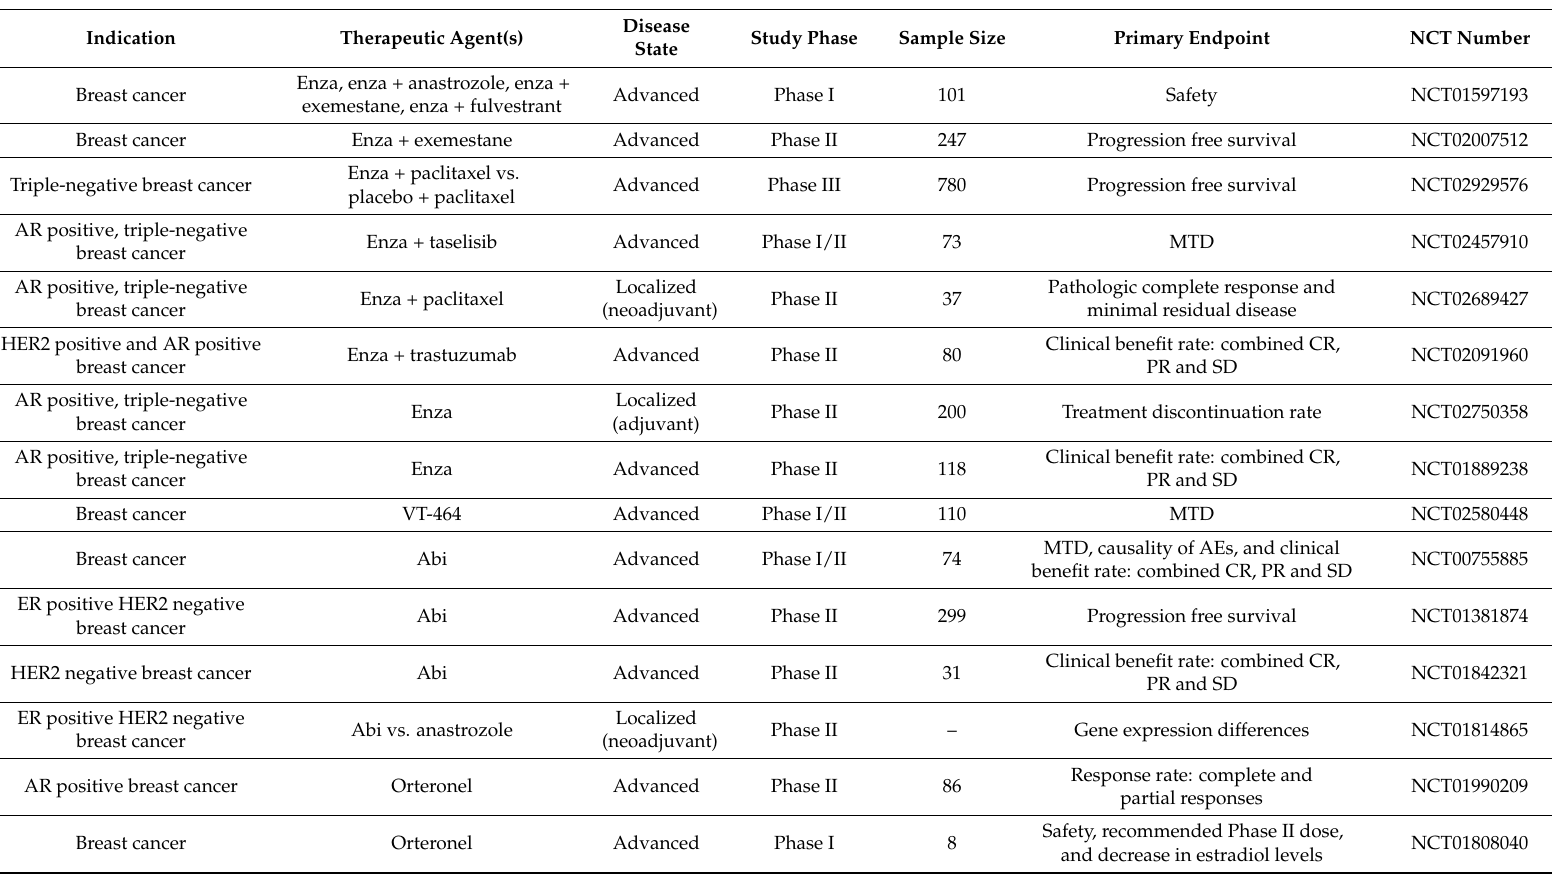
Table 1. Ongoing studies testing AR-directed therapies in breast cancer. Abi, abiraterone; Enza, enzalutamide; AR, androgen receptor; AE, adverse event; MTD, maximum tolerated dose; CR, complete response; PR, partial response; and SD, stable